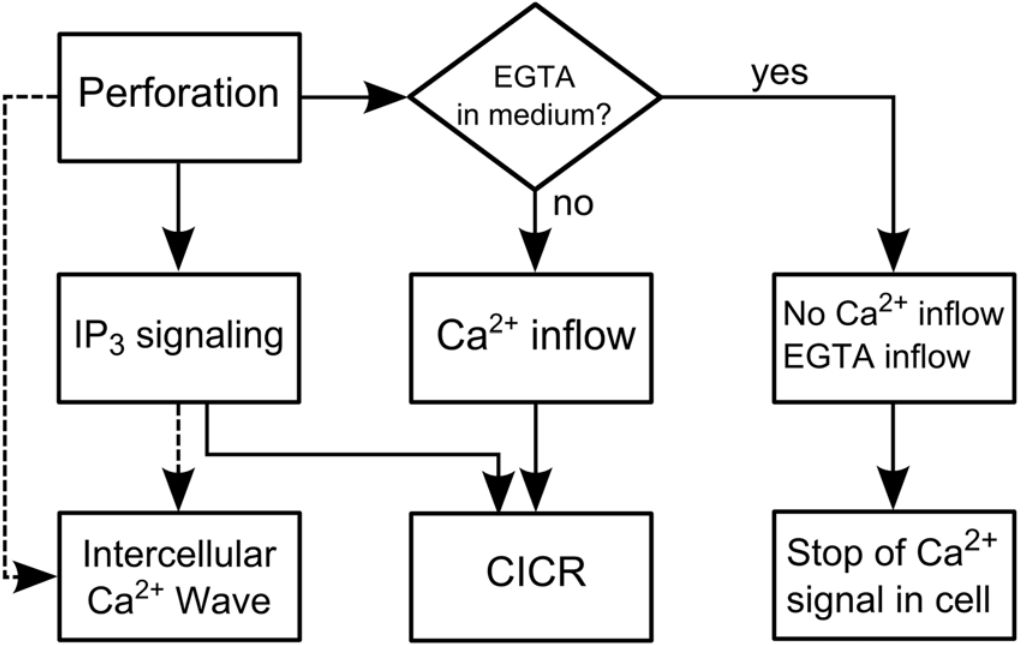
Fig 7. Potential causes of the calcium signaling during gold nanoparticle mediated laser manipulation. Two different pathways in the presence or absence of a calcium chelating agent like EGTA are depicted. The intercellular calcium wave occurs in the presence of EGTA because the cascade is possibly mediated by the IP 3 pathway or paracrine ATP signaling. ATP might also be released from the cell after perforation.